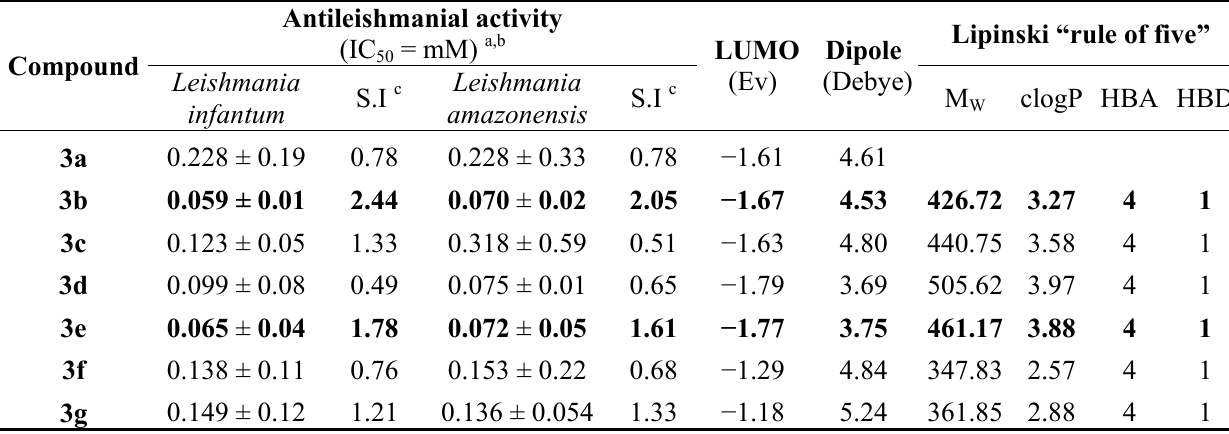
) effect against Leishmania spp. and the Table 1. Comparison of the antileishmanial (IC 50 theoretical parameters evaluation of the molecular electronic properties of the new 4-(1 H - pyrazol-1-yl)benzenesulfonamide series 3a – e , including the lowest unoccupied molecular orbital (LUMO) energy (eV), dipole (Debye), and Lipinski “rule of five”